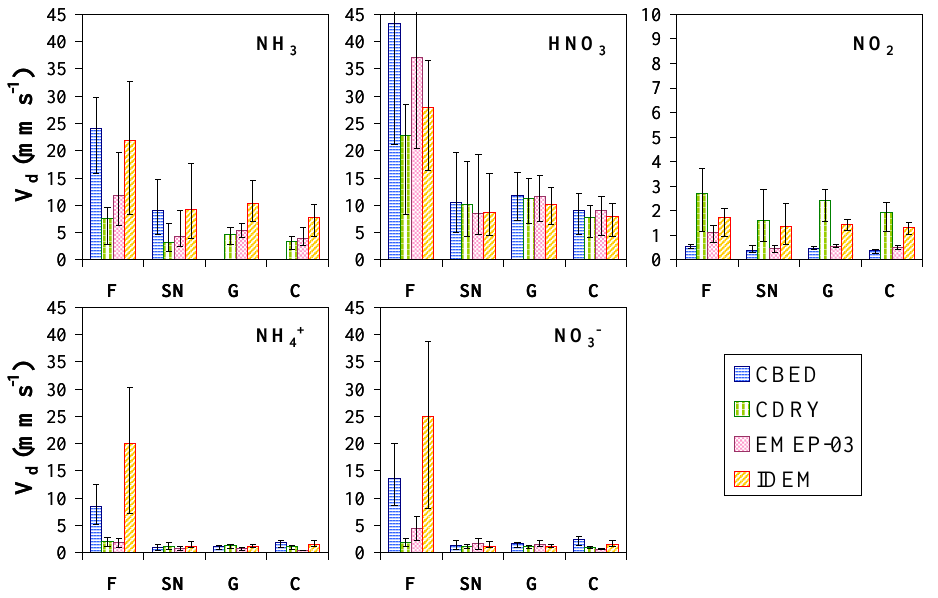
Fig. 3. Overview of mean modelled deposition velocities (evaluated at d + z 0 + 3m for all sites) for dominant atmospheric N r species. Data are medians and 5th and 95th percentiles across the sites of mean V d values at each site. Note the different scale on the vertical axis for NO 2